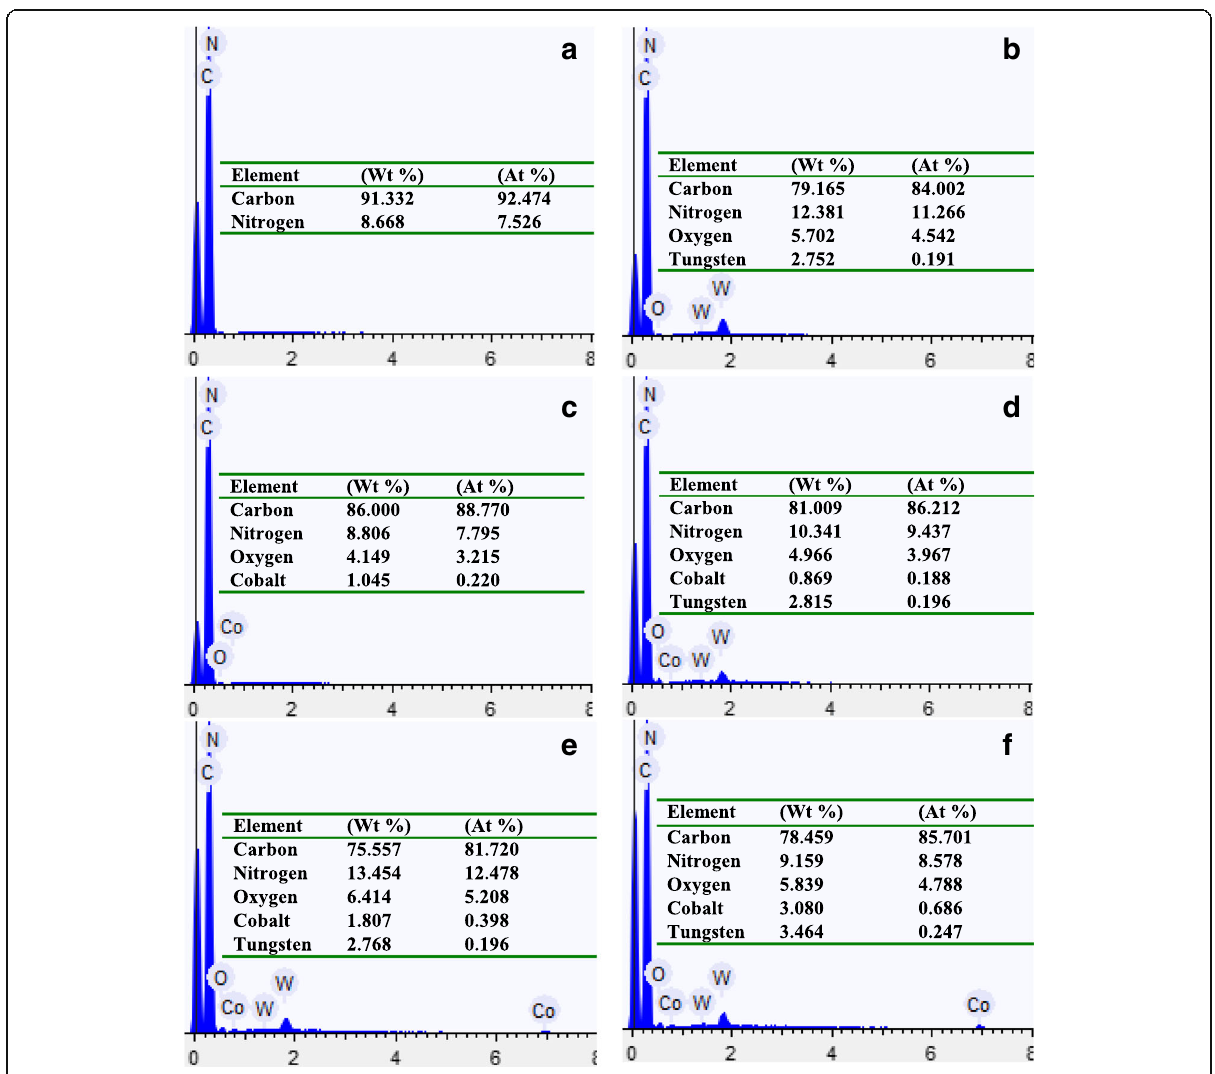
Fig. 5 EDS of a PAN/PS, b PAN/PS W 1 , c PAN/PS Co 1 , d PAN/PS W 1 Co 1 , e PAN/PS W 1 Co 2 , f PAN/PS W 1 Co